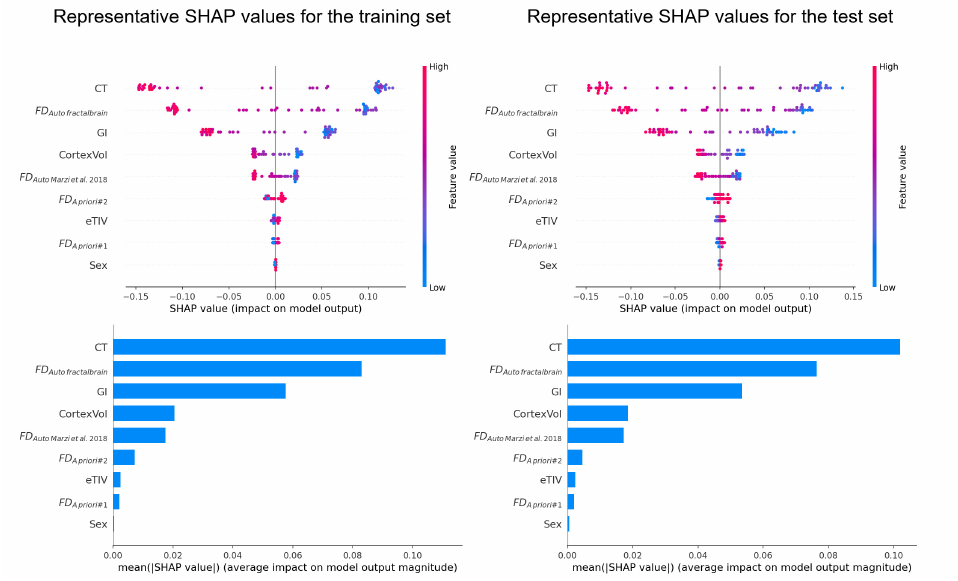
Figure 5. Results for the ICBM classification task in a five-fold nCV over 100 repetitions. Top row: beeswarm summary plots of representative SHAP values for the training (on the left ) and test sets (on the right ). The given SHAP explanation is represented by a single dot on each feature row for each sample (i.e., subject). The SHAP value of each feature determines the x position of the dot, and dots pile up along each feature row to show density. Color is used to display the original value of the feature. Bottom row: summary bar plot representing global feature importance as represented by the mean absolute SHAP value for that feature over all the given samples for the training (on the left ) and test sets (on the right